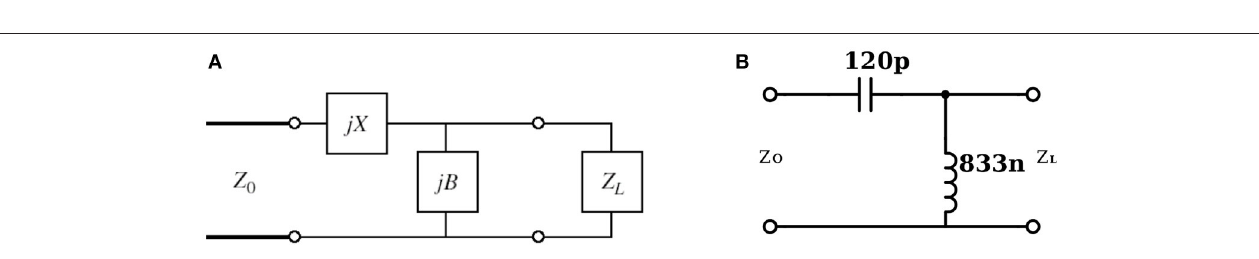
FIGURE 7 | L shape matching network design. (A) one of the L shape matching network. (B) The designed matching network used in TinyPR